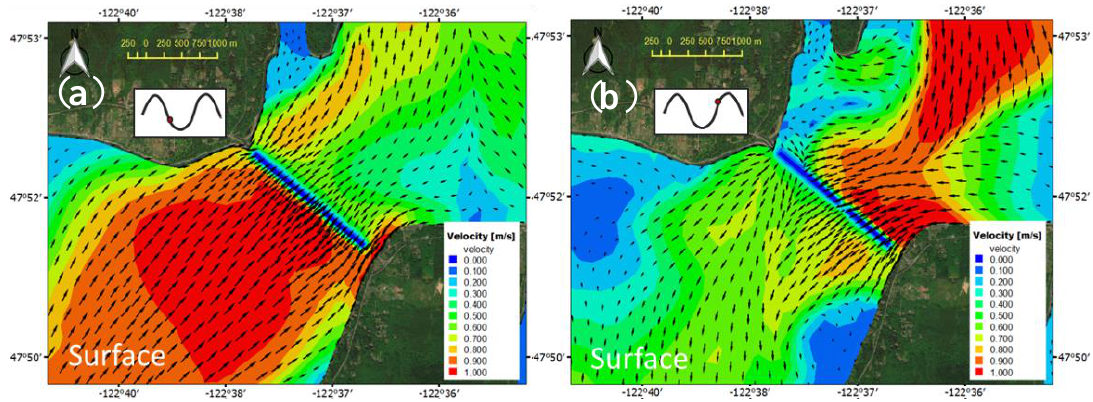
Figure 13. Predicted horizontal velocity contour and vector plots for the baseline scenario with HCB present for ( a ) ebb and ( b ) flood currents in the surface layer. (Typical spring tide on 27 April 2017).